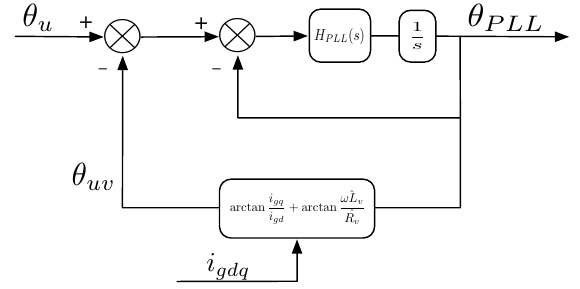
Figure 4. Schematic diagram of the AIC-PLL system.